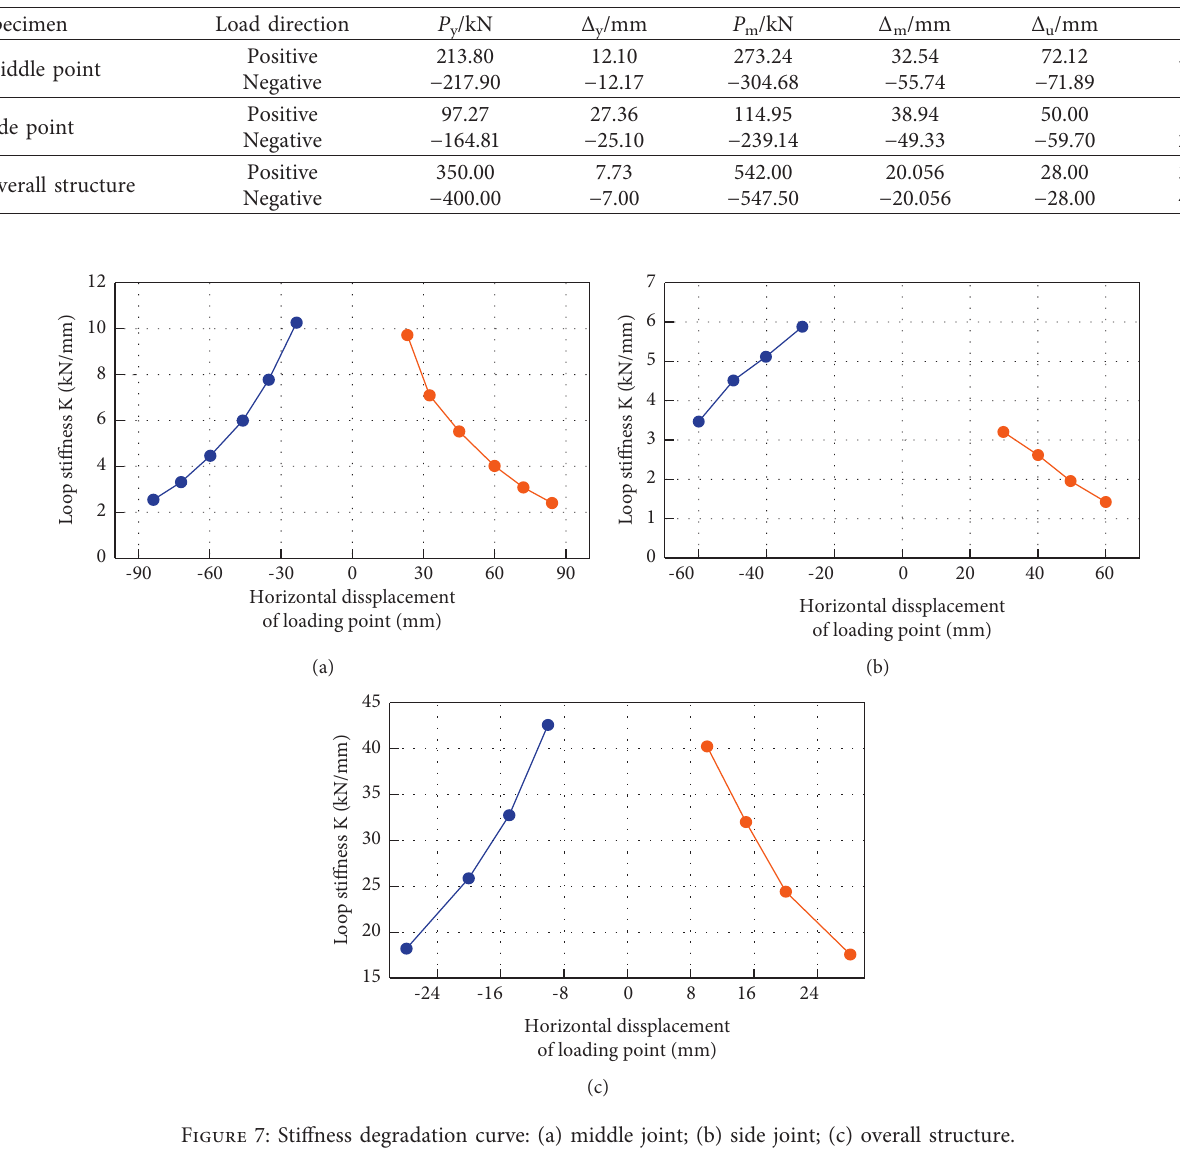
Table 1: Characteristic displacement and load of specimen.